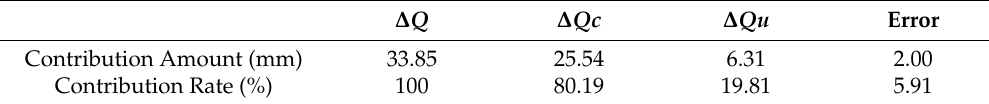
Table 6. The results of attribution analysis of runoff change.